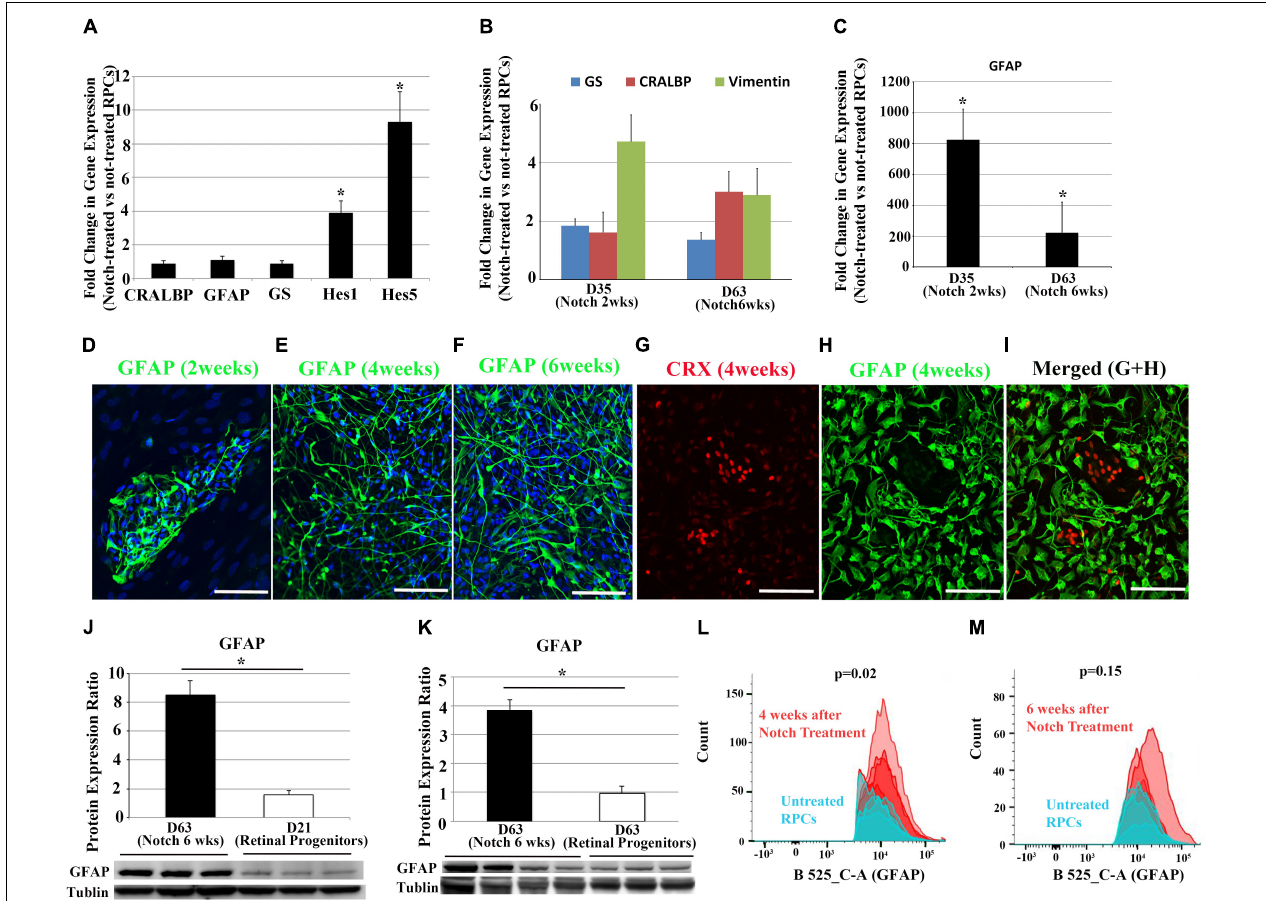
FIGURE 2 | Changes in Notch target genes and glia cell-associated markers after Notch ligand treatment in RPCs. (A) qRT-PCR analyses indicate Notch ligand treatment of RPCs for 9 days significantly upregulated the expression of Notch downstream effector genes including HES1 and HES5 , but with much less effect on glia cell-associated makers CRALBP, GFAP and GS . (B,C) Gene expression levels of CRALBP, VIMENTIN, GS and GFAP over the course of Notch ligand treatment. (D–F) Immunostaining for the glial cell marker GFAP 2, 4, and 6 weeks after Notch ligand treatment in RPCs. (G–I) Double label immunostaining for the photoreceptor precursor marker CRX and glial cell marker GFAP 4 weeks after Notch ligand treatment. Scale bars: 100 µ m. (J,K) Western blots for GFAP using proteins extracted from un-treated RPCs and those treated with Notch ligands for 6 weeks. n = 3–4. (L,M) FACS analyses showed increased numbers of GFAP positive cells after treating RPCs with Notch ligands for 4 and 6 weeks. ∗ p < 0.05, error bars represent SEM, n ≥